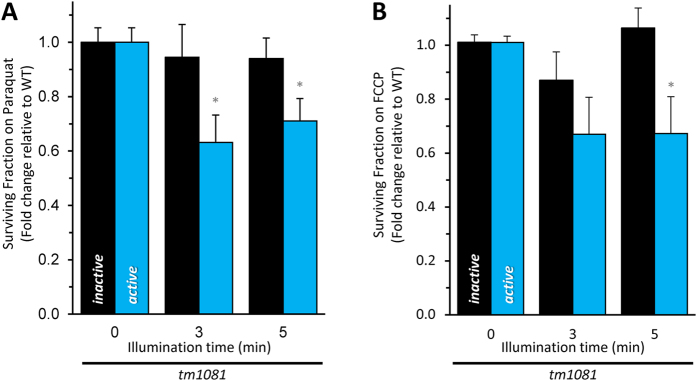
CALI of complex II sensitizes C. elegans to mild stress.Wild-type (+), tm1081; inactive, and tm1081; active strains were: (A) illuminated as L1 larvae for the indicated period and cultured on NGM plates containing 200 μM paraquat. 96-hour survival is plotted relative to the zero-illumination baseline. Baseline survival on 200 μM paraquat was wild-type (+), 78 ± 4%; tm1081; inactive , 68 ± 4%; tm1081; active, 60 ± 3%. Data are mean ± SEM. N = 11–13. An “N” is considered an independent trial of >50 worms. *Adjusted P < 0.05 vs the no light or vs the light-matched inactive counterpart (2-way ANOVA with Sidak multiple comparisons test). (B) Synchronized L4 were illuminated for the indicated time and cultured on NGM plates seeded with OP50 containing 1 μM FCCP. Viability was assessed 1 day later and plotted relative to zero-illumination baseline. Baseline survival on 1 μM FCCP was wild-type (+), 99 ± 1% survival; tm1081; inactive, 93 ± 3%; tm1081; active, 94 ± 2%. Data are mean ± SEM. N = 9. An “N” is considered an independent trial of >50 worms. *Adjusted P < 0.05 vs the no light or vs the light-matched inactive counterpart (2-way ANOVA with Sidak multiple comparisons test). Data were normalized to wild-type (+) to account for miniSOG-independent effects of blue light. Alleles are abbreviated as outlined in Fig. 1.